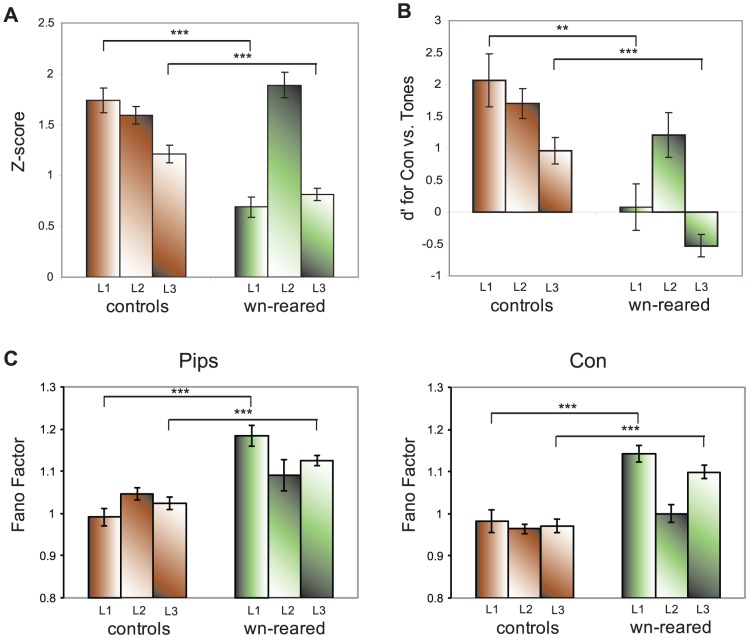
Neural responsivity, selectivity, and reliability in subfields L1 (∼Layer III), L2 (∼Layer IV), and L3 (∼Layer V).A. Comparison of control and wn-reared mean z-scores (pooled over all five stimuli: Con, Pips, Tones, Ripples, and WN) broken down by subdivisions in field L (as assessed by histological analysis). Average z-scores for all stimulus-excited responsive units show that responses to the more complex stimuli of Con, Ripples, and WN are reduced in L1 and L3 in wn-reared birds compared to control birds. Error bars represent 2 SEs. B. d′ values for the Con-Tones comparison for controls and wn-reared adults broken down by subdivisions in field L. Selectivity analysis shows noise-rearing had the greatest effect on subfields L1 and L3. Error bars represent 2 SEs. C. Fano factor for Pips (left) and Tones (right) for controls and wn-reared adults broken down by subdivisions in field L. Noise-rearing decreased the response reliability for neurons in subfields L1 and L3. Error bars represent 2 SEs.